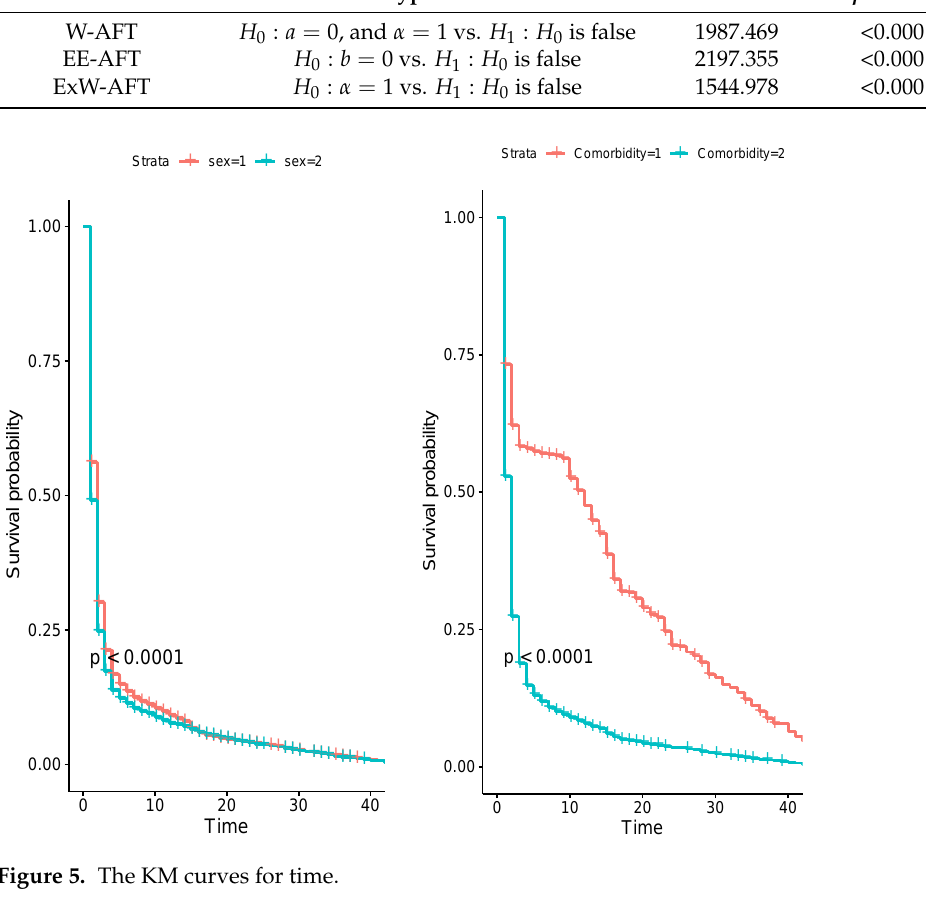
Table 20. The LRT statistics for COVID-19 data at significance level 1%. Model Hypothesis LRT p -Value